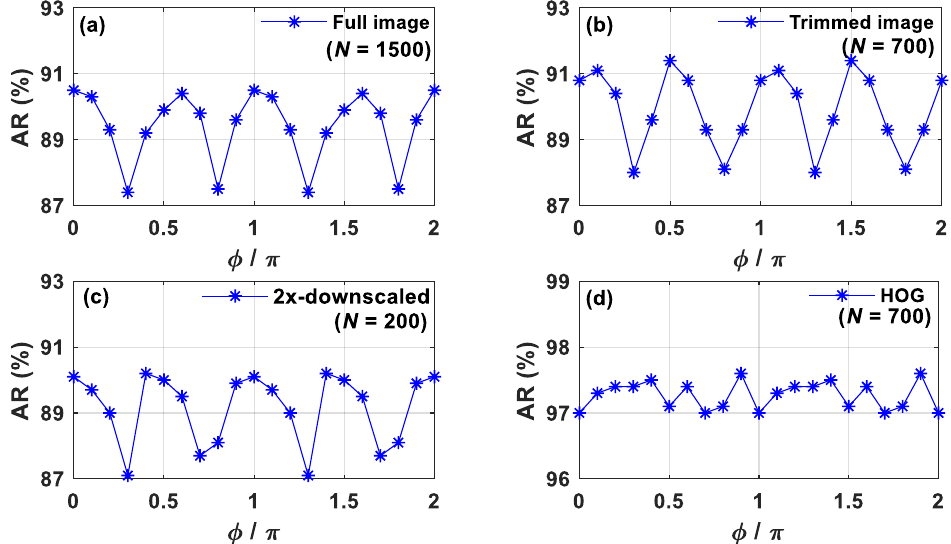
Figure 4. Variation in the AR with the offset phase ϕ under β = 0.2 and γ = 0.92. ( a ): input full image, ( b ): input trimmed image, ( c ): input 2×-downscaled features, and ( d ): input HOG features.